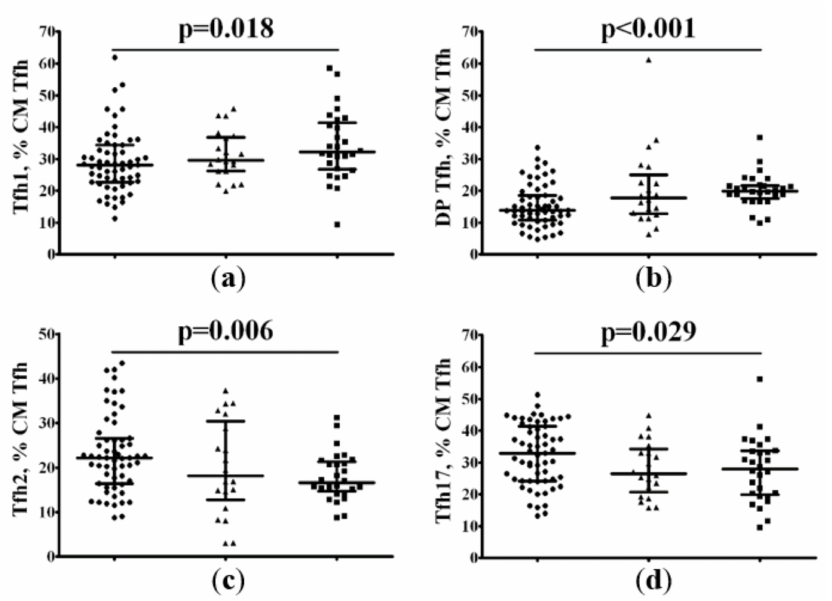
Figure 6. Imbalance of central memory Tfh cell subsets in patients with COVID-19. Scatter plots show the percentages of CXCR3+CCR6 − Tfh1 ( a ), double-positive CXCR3+CCR6+ Tfh ( b ), CXCR3 − CCR6 − Tfh2 ( c ), and CXCR3 − CCR6+ Tfh17 ( d ) cells among the total CD45RA − CD62L+ Tfh population, respectively, in peripheral blood samples in patients with 25(OH)D > 11.4 ng/mL (black circles), patients with 25(OH)D ≤ 11.4 ng/mL (black triangles), and HC subjects (black squares). Numbers represent the percentage of the indicated Th cell subset among the total lymphocyte